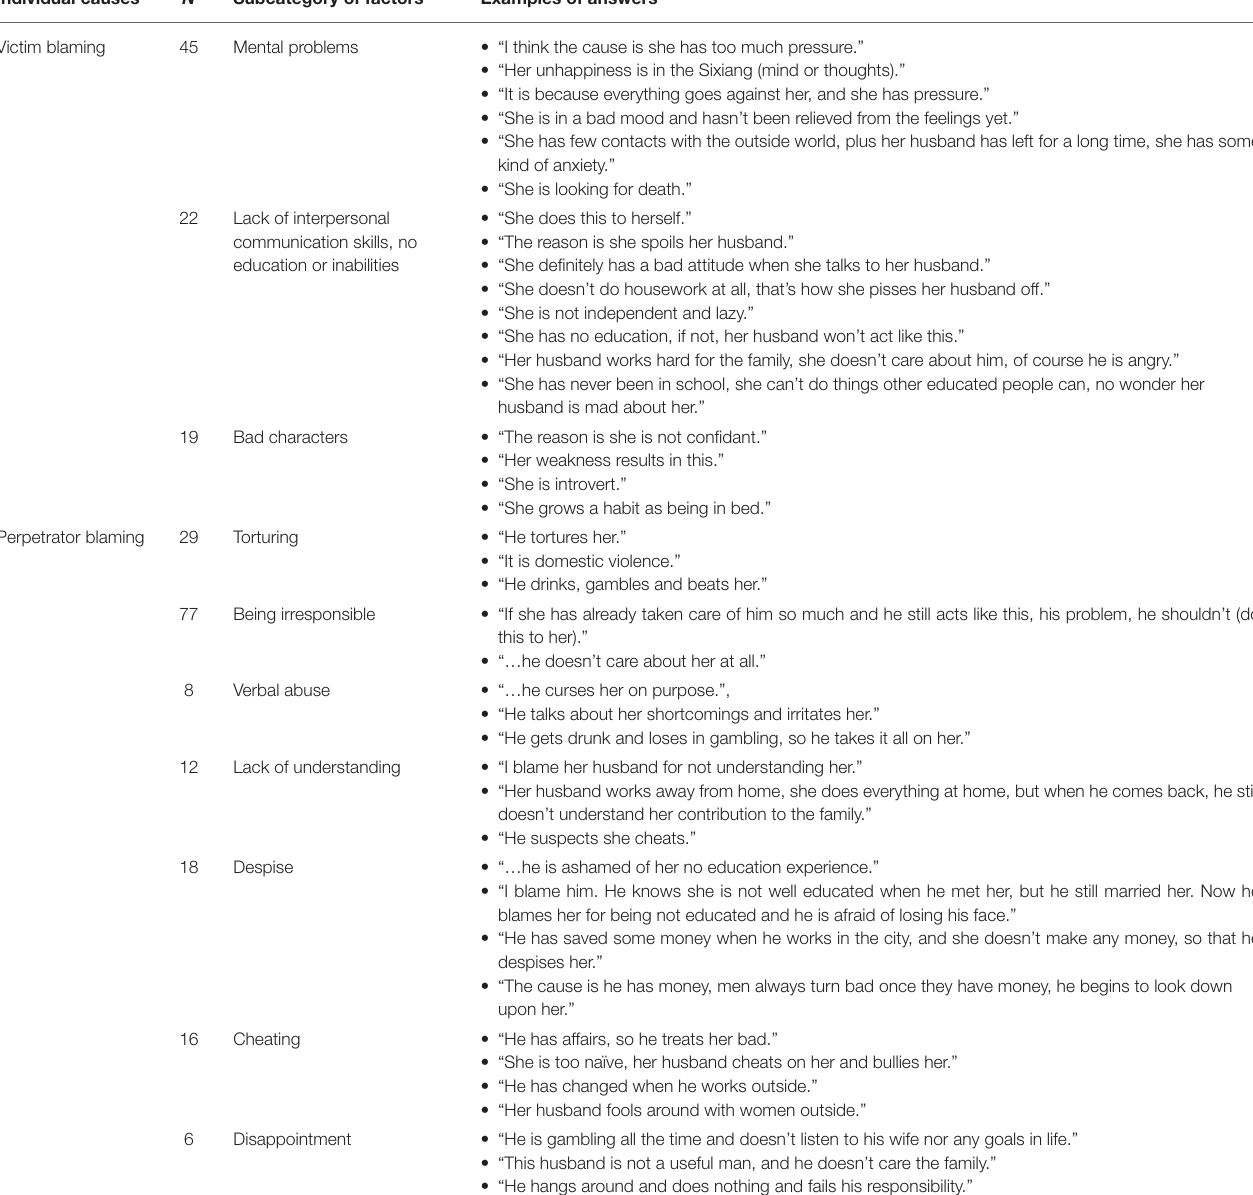
TABLE 3 | The causes of IPV at individual level explained by participants. Individual causes N Subcategory of factors Examples of